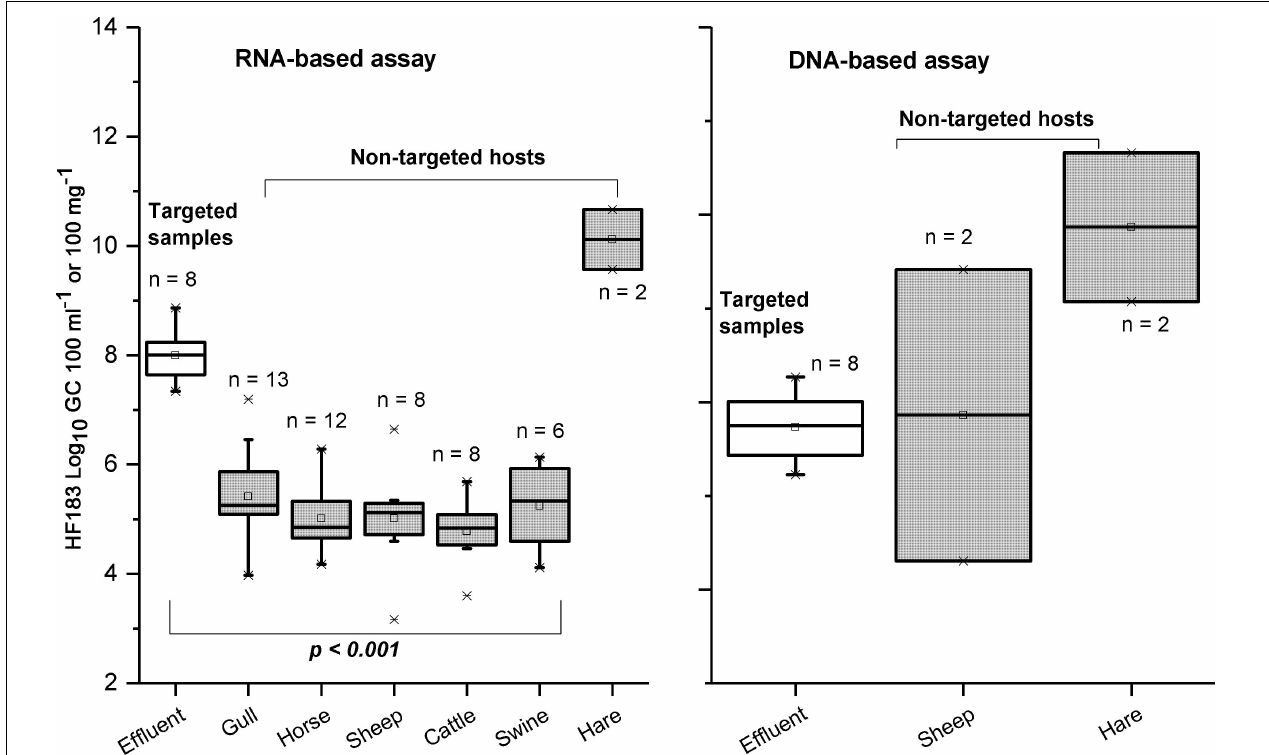
FIGURE 3 | Copy numbers generated with HF183 assay for targeted (sewage) and non-targeted (animal fecal) samples when using RNA and DNA as a template. Only the samples with results > LOQ included. The p -Value is based on the Kruskal–Wallis